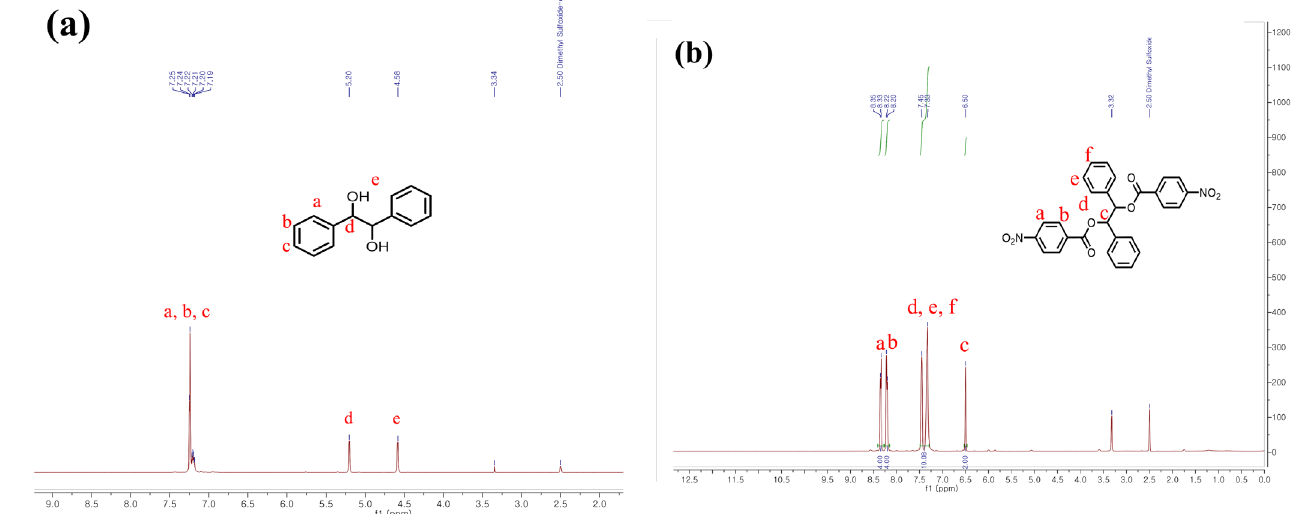
Figure 1. 1 H-NMR spectra of ( a ) 1,2-diphenylethane-1,2-diol and ( b )